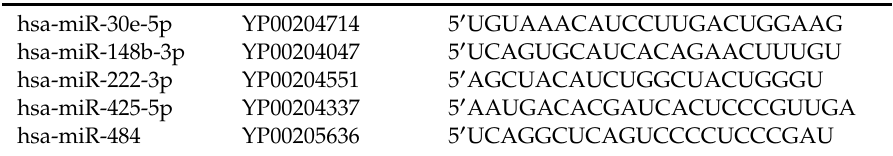
Table A1. miRCURY LNA miRNA PCR assays for normalization.